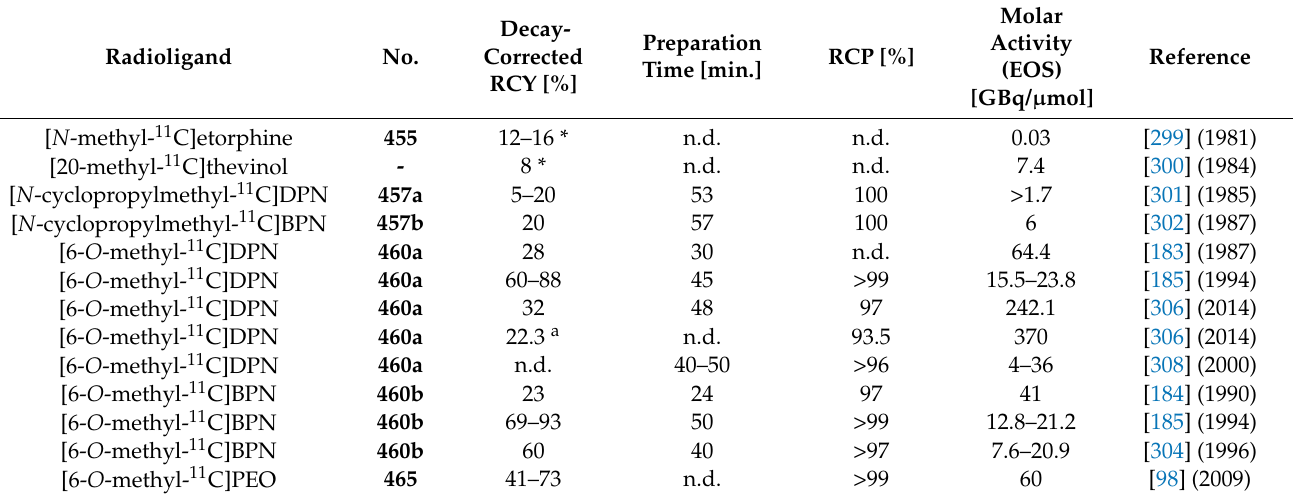
Table 4. Radiosynthesis data of carbon-11 labeled orvinol